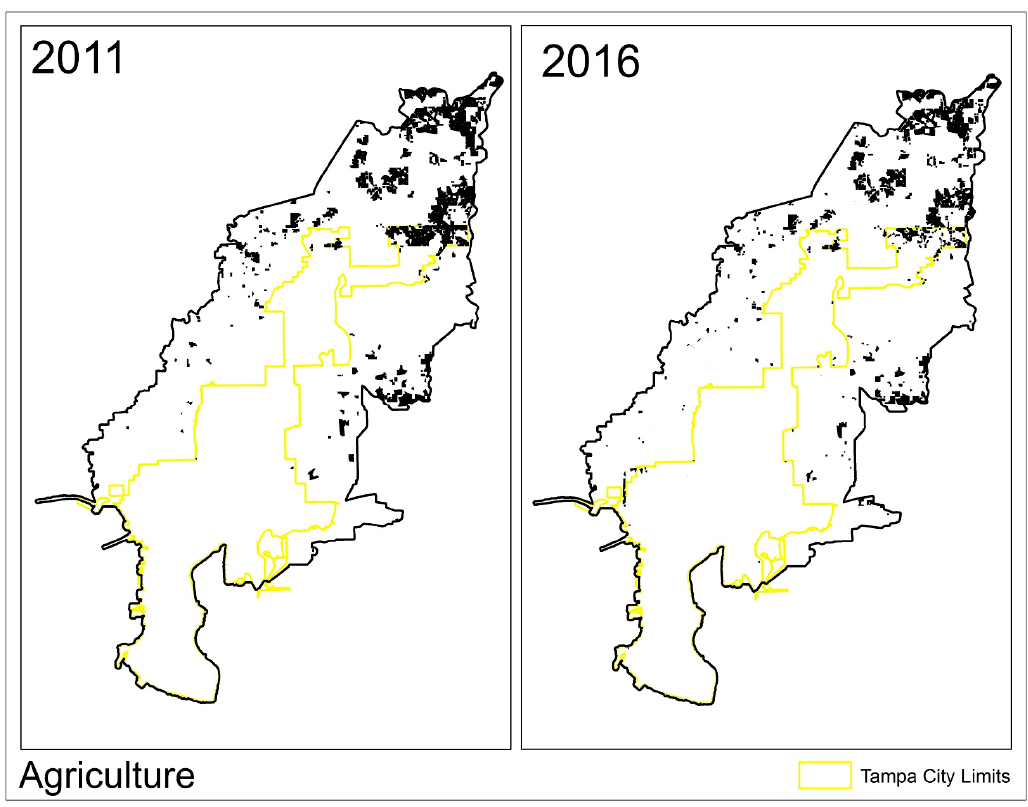
Figure A6. Observed (2011) and Modeled (2016) LULC distribution for the “Agriculture” class.